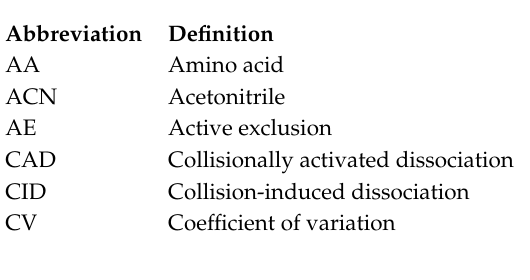
Supplementary Materials: The following are available online, Figure S1: Top-down sequencing responsiveness of AAs for each of the eight most abundant proteins from the mixed standard sample, Figure S2: CID-friendly amino acids from top-down sequenced milk proteins, Figure S3: Data processing of MS/MS files using Genedata Refiner and DataAnalysis/Biotools exemplified on the Holstein milk sample processed using Method